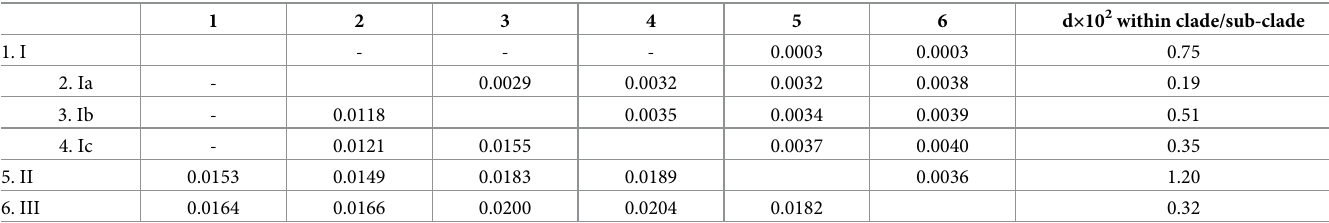
Bayesian haplotype tree and ML as the Clade III (see Fig 2). Another two major clades (Clades I and II) identified by Bayesian, NJ, and ML methods were not monophyletic in the network result. Haplotypes of these two clades comprised the super-cluster of this network. In the super-cluster, the Clade I of phylogenetic tree contained at least 12 mutational differences from haplotypes of Clade II (h30 and h31). Haplotype 4 (h4) was the major haplotype (repre- sented by 13 individuals, mainly from the Wanquan River), occupying the central position of all haplotypes, and occurred at three sampling locations on Hainan (sites 4, 5, 23) and a fourth